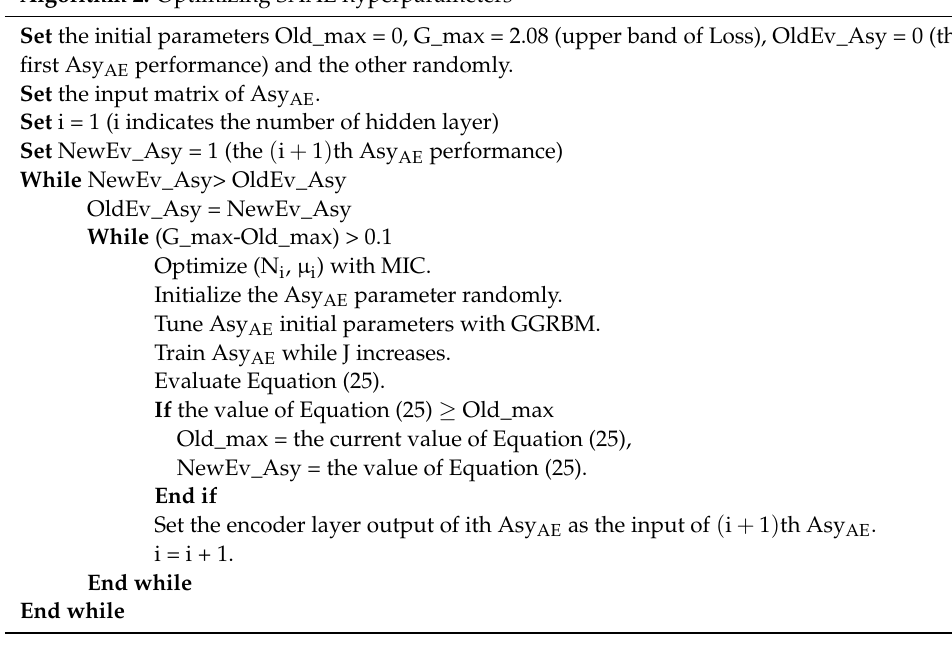
Algorithm 2: Optimizing SAAE